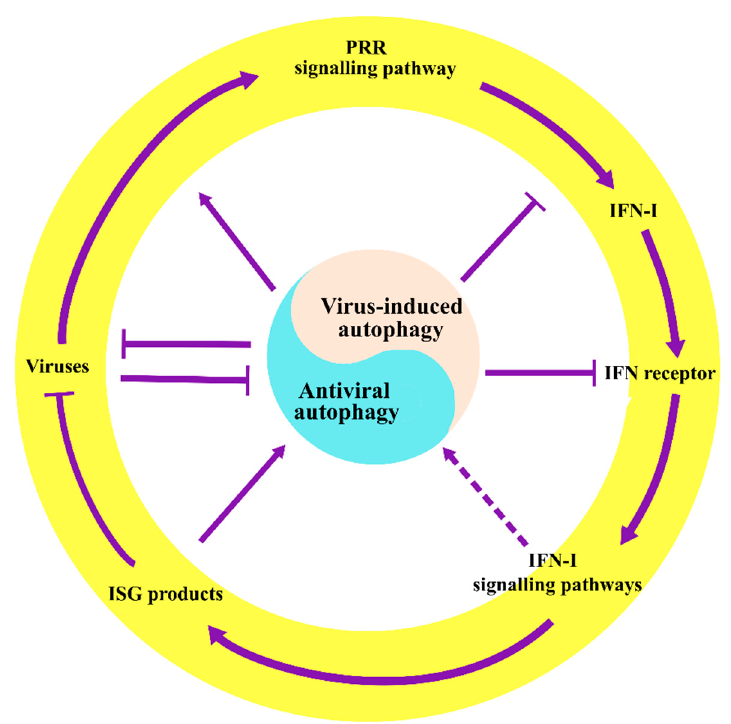
Figure 3. The crosstalk between autophagy and IFN-I-mediated antiviral immunity. Autophagy plays a vital role in regulating innate antiviral immunity induced by IFN-I. Virus-induced autophagy can suppress the IFN-I antiviral responses, and the IFN-I system can also manipulate autophagy to eliminate viruses. The crosstalk between autophagy and IFN-I responses may serve as a major bridge linking autophagy to innate antiviral immunity. Solid arrows indicate stimulation, T arrows indicate inhibition, and dashed arrows indicate potential stimulation .